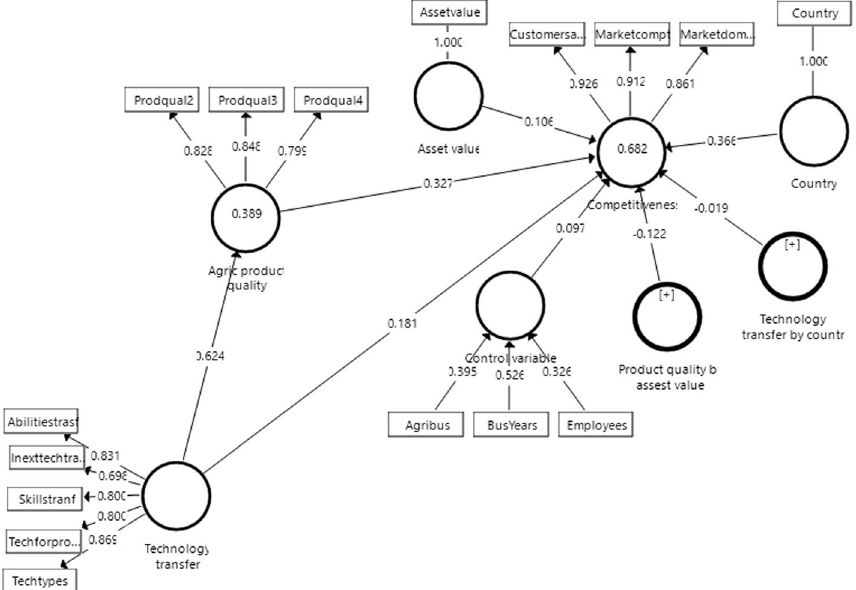
Fig. 3 The moderating effects of country and asset value on the relationship between technology transfer and